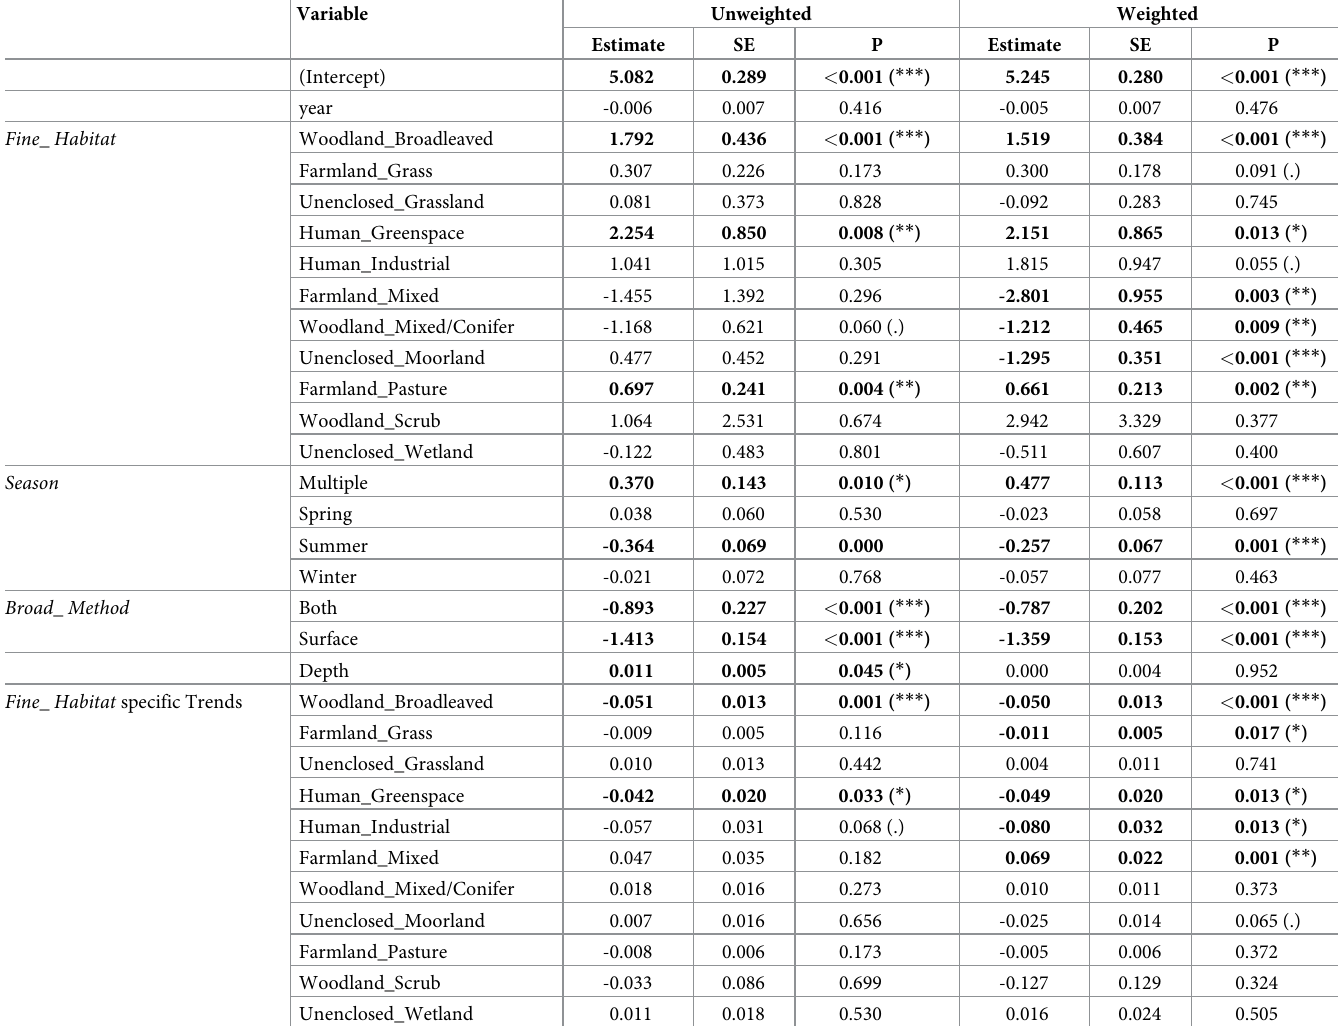
Table 6. Model 4 output of earthworm abundance trends. The output from Model 4 using the Fine_Habitat categories with the interaction with year, unweighted and weighted (by the natural log of Sample Extent +1), compared to the base of Farmland_Arable, Autumn and Core. The level of significance is represented by:. p < 0.1; * p < 0.05; ** p < 0.01; *** p < 0.001, SE = Standard